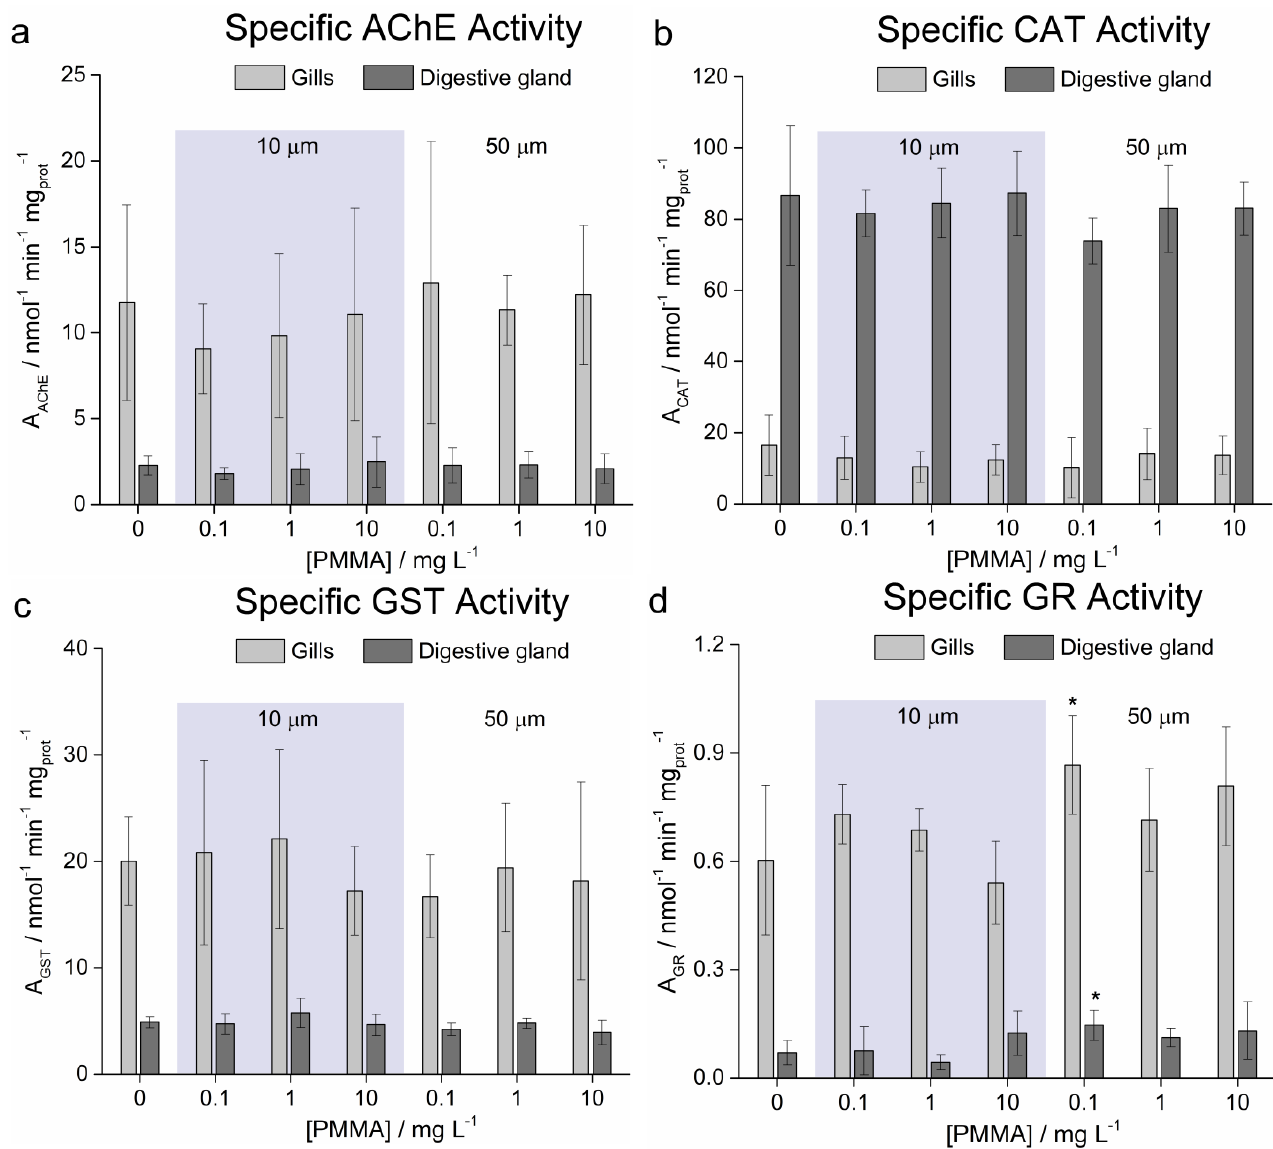
Figure 9. Enzymatic activity in gills and digestive glands after exposure to different sizes (10 and 50 µ m)/concentrations (0.1, 1, 10 mg L − 1 ) of PMMA microparticles: ( a ) acetylcholinesterase (AChE), ( b ) catalase (CAT), ( c ) glutathione-S-transferase (GST), and ( d ) glutathione reductase (GR). Statistical significance is indicated at the level * p <